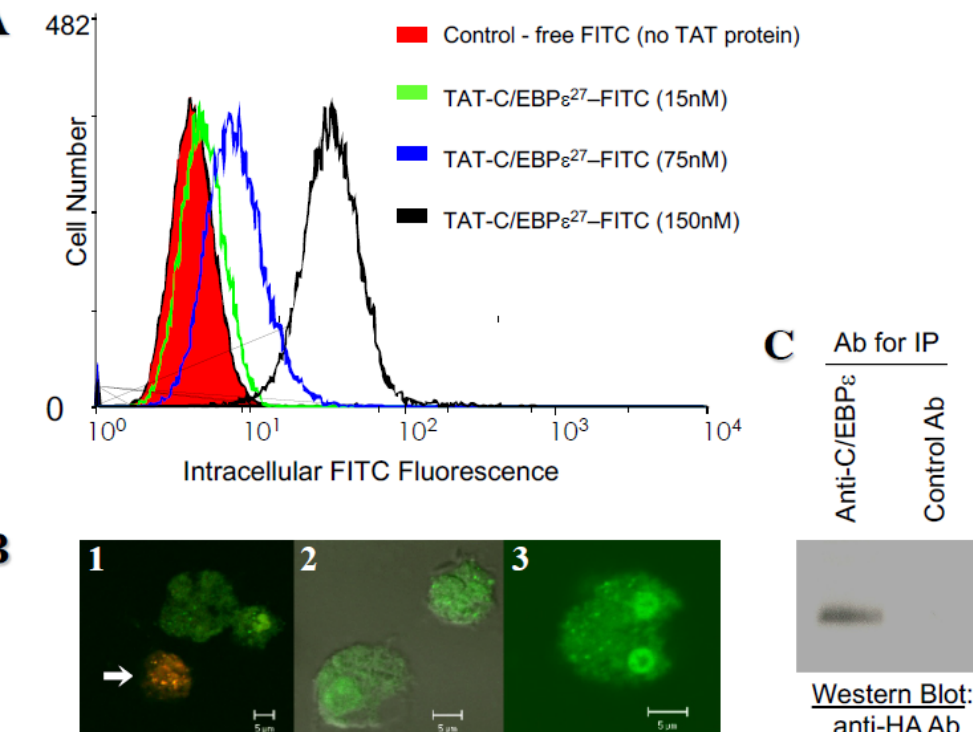
Figure 2. Transduction of the AML14.3D10 eosinophil myelocyte cell line by TAT-C/EBP ε 27 . Flow cytometry of intracellular FITC fluorescence in AML14.3D10 eosinophils transduced with increasing doses of FITC-TAT-C/EBP ε 27 for one hr. ( A ). The pH of the cell suspension buffer and sheath fluid for the flow cytometer was adjusted to 6.8 to quench extracellular FITC fluorescence as previously described (26). Aliquots of the same cells used for flow cytometry were cytocentrifuged onto slides and analyzed by confocal microscopy for intracellular FITC fluorescence ( B ); images are shown for the 75 nM (panel 1) and 150 nM (panels 2 – 3) doses. A non-transduced cell in panel B1 shows autofluorescence characteristic of AML14.3D10 eosinophils (arrow). Both nuclear and cytosolic localization of the FITC-TAT-C/EBP ε 27 fusion protein is shown (panels B2 and B3). In ( C ), AML14.3D10 eosinophils were transduced with 1 μM TAT-C/EBP ε 27 , lysed in immunoprecipitation buffer, and the cell lysate divided equally among samples that were either immunoprecipitated with antibodies to HA (the TAT-C/EBP ε 27 construct is tagged at its N-terminus with an HA epitope) or C/EBP ε , control non-immune antibody or saved as the input control. Western blotting of the immunoprecipitates used an anti-HA antibody for detection of the fusion protein.